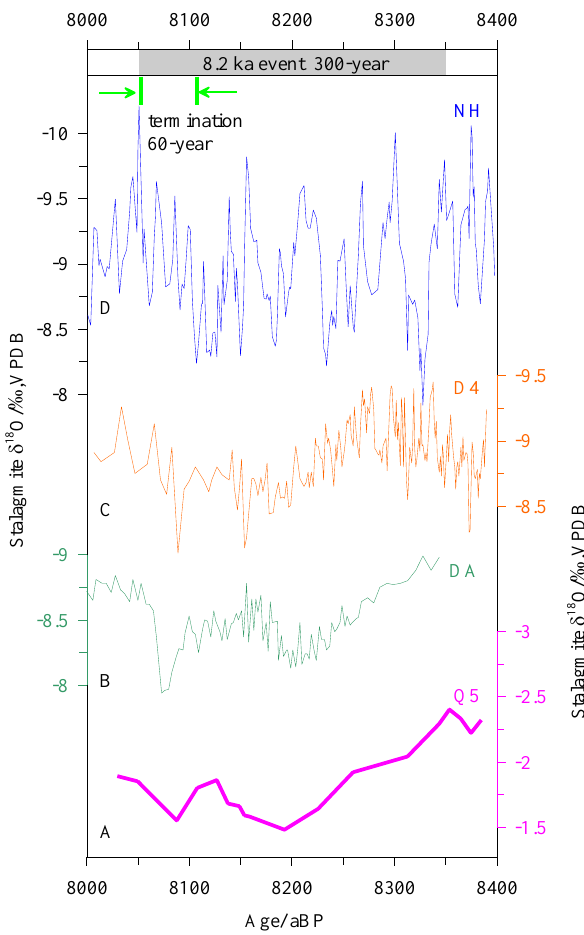
Fig. 5. δ 18 O time series over 8.2ka event from stalagmites. (A) Q5, Qunf Cave, Oman; (B) DA, Dongge Cave, China; (C) D4, Dongge Cave, China; (D) NH33, Nuanhe Cave, China. Q5, DA and D4 records were re-dated by Cheng et al. (2009). Gray bar indicates the broadly consistent duration of the 8.2ka event from all monsoon records. The end of the 8.2ka event in NH33 δ 18 O lasts about 60